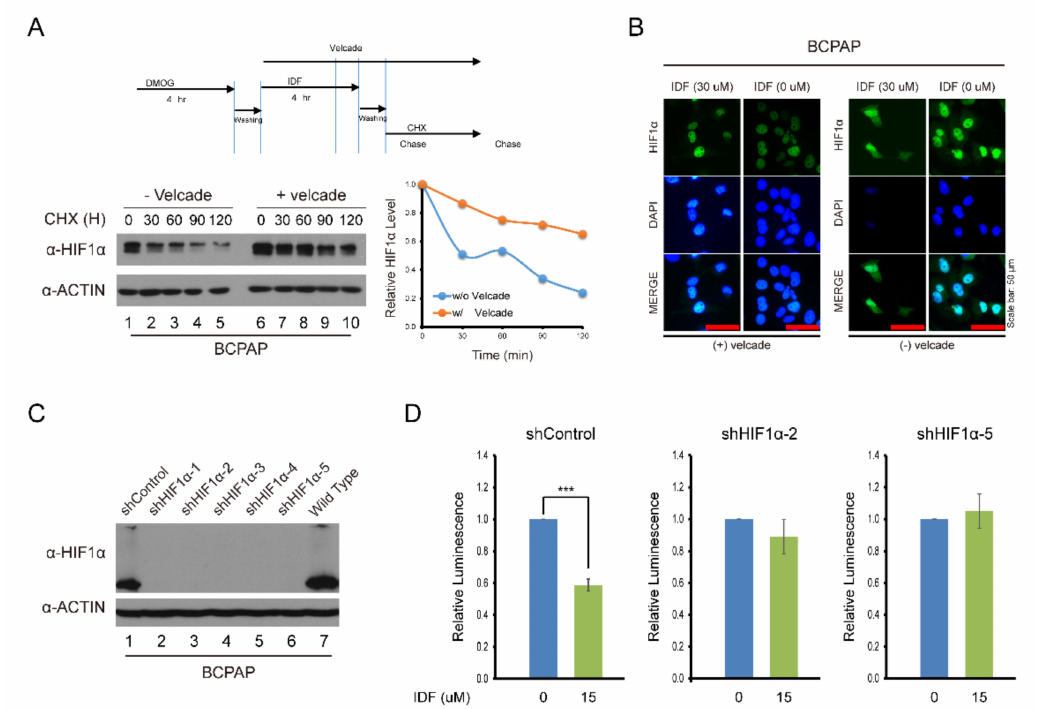
Figure 4. Alteration of the drug e ff ect on HIF-1 α expression after knockdown of HIF-1 α and treatment with cycloheximide and velcade. ( A ) Analysis of HIF-1 α expression after IDF-11774 treatment with cycloheximide and velcade. BCPAP cells were incubated with DMOG for 4 h. Cells were treated for 4 h with IDF-11774 alone or with IDF-11774 and velcade. The half-life of HIF1 α was estimated by treating with cycloheximide at the indicated time. ( B ) Immunofluorescence of HIF-1 α expression with IDF-11774 and velcade. BCPAP cells were treated with DMOG for 4 h and incubated for 24 h in the presence or absence of IDF-11774. Cells were stained with HIF1 α antibody. Nuclei were counterstained with DAPI. Velcade treatment was administered for 5 h before immunostaining. Scale bar represents 50 µ m (100 × ). ( C ) Analysis of HIF-1 α expression in HIF-1 α knockdown BCPAP cells. BCPAP cells stably expressing Control-shRNA or HIF1 α -shRNAs were detected by Western blot analysis. ( D ) HIF-1 α knockdown attenuated the e ff ect of cell viability of BCPAP cells treated with IDF-11774. BCPAP Cells stably expressing shRNA were incubated with DMSO or IDF-11774. Cell viability was measured at the indicated time using the CellTiter-Glo system. Data in the graph are presented as mean ± standard deviation of fold increase normalized by cells at day 0 ( n = 5, ** p <